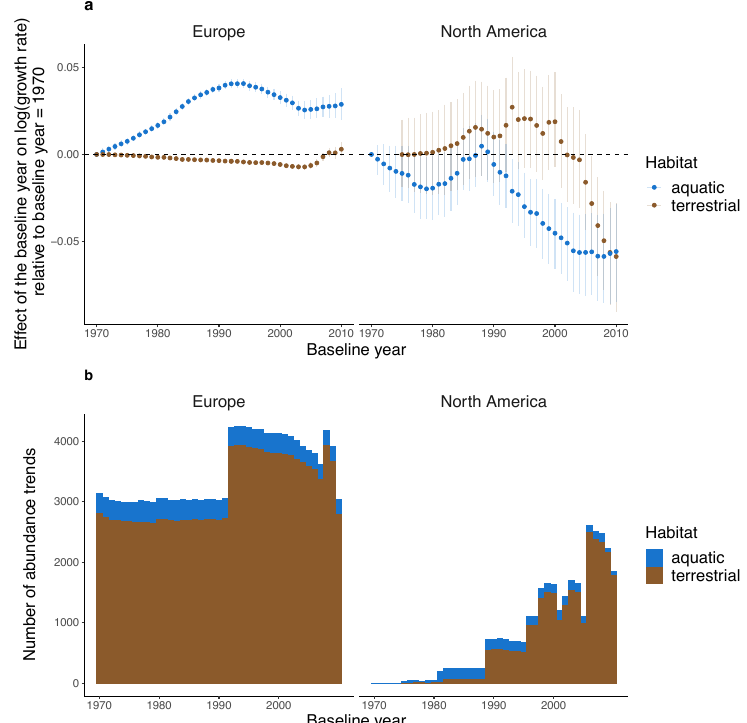
Figure 5: Effect of the baseline year on average abundance trends. (a) Relationships between the baseline year of times series and estimated abundance trends (log of the growth rate) relative to the abundance trends estimated with the oldest baseline of the dataset (1970), for each continent and habitat. Error bars are 95% confidence intervals. (b) Number of truncated time series used for each baseline